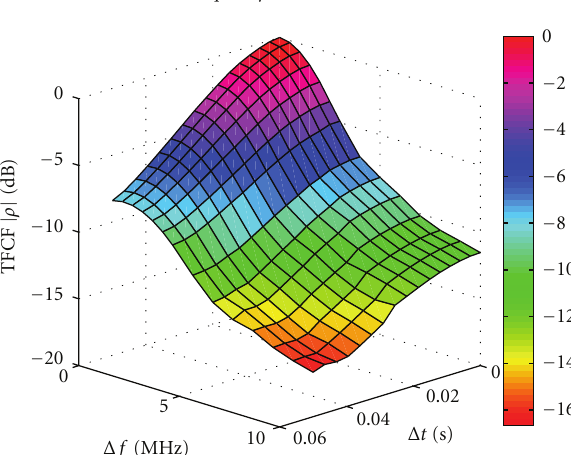
Figure 7: Normalized time frequency correlation function of V-V link for the superposition of SBT, SBR and DB rays.